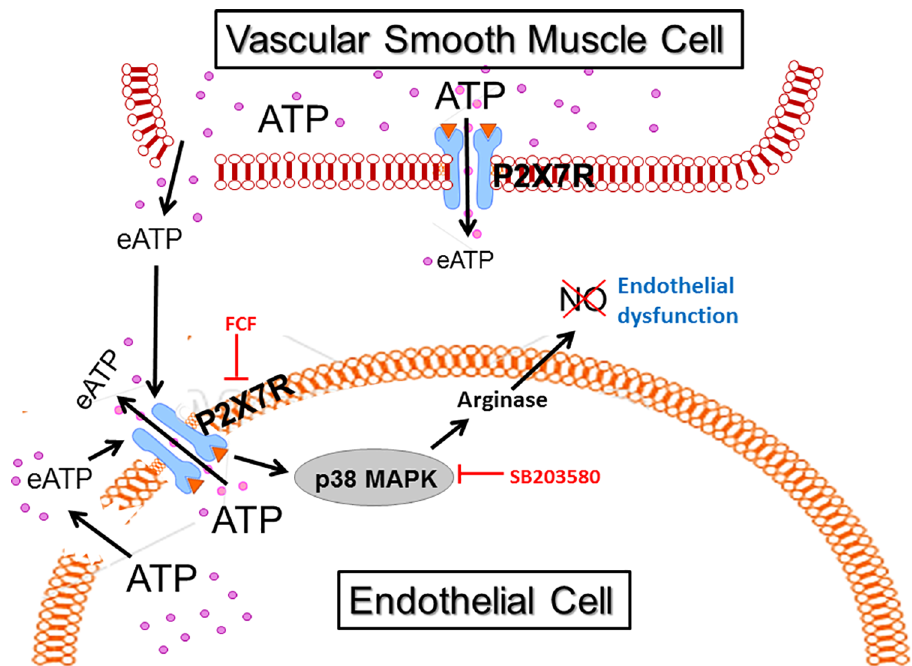
Fig 9. Harvesttraction stretch injury led to ATP release,activation of P2X7R and endothelial dysfunction. During endoscopic harvest of humansaphenousvein (HSV), traction stretch injury leads to release of ATP from vascular cells. The high concentrations of extracellular ATP (eATP) activate P2X7 receptors (P2X7R) which leads to further release of ATP from P2X7R channels and activationof p38MAPK. Brilliantblue FCF (FCF) is an inhibitorof P2X7R and SB203580is a small moleculeinhibitorof p38 MAPK. P38 MAPK leads to arginaseactivationwhich decreases nitric oxide (NO) resultingin endothelial dysfunction.